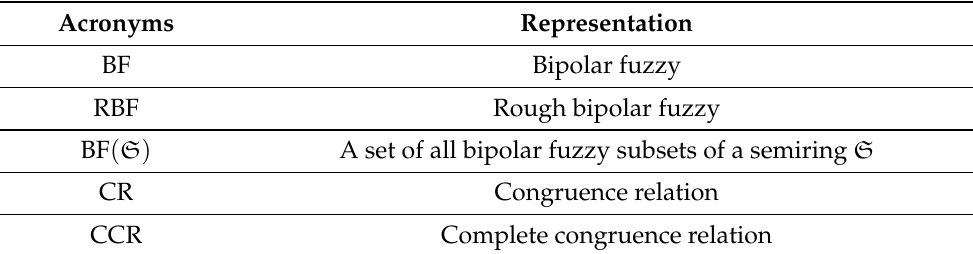
Table 1. List of